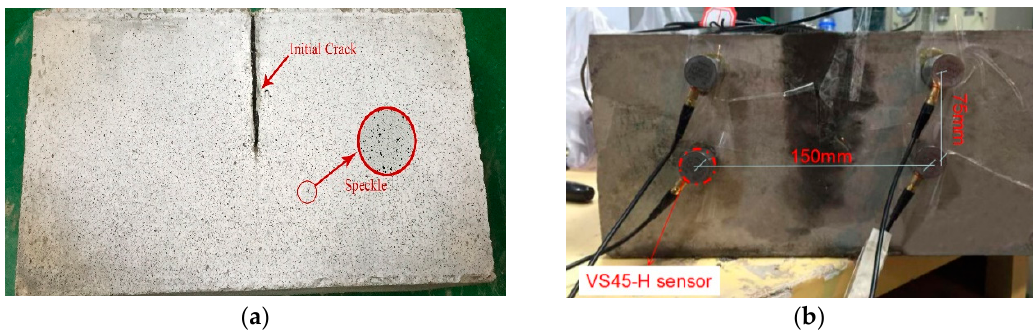
Figure 4. Specimen preparation. ( a ) Speckles applied to the outer surface of the specimen; ( b ) arrangement of acoustic emission sensor.